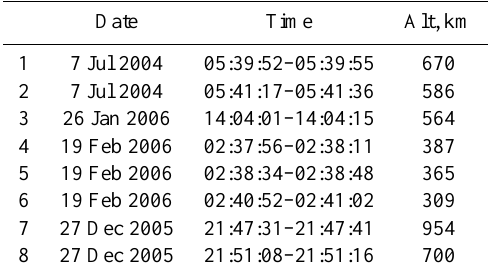
Table 1. Dates and times of aurora